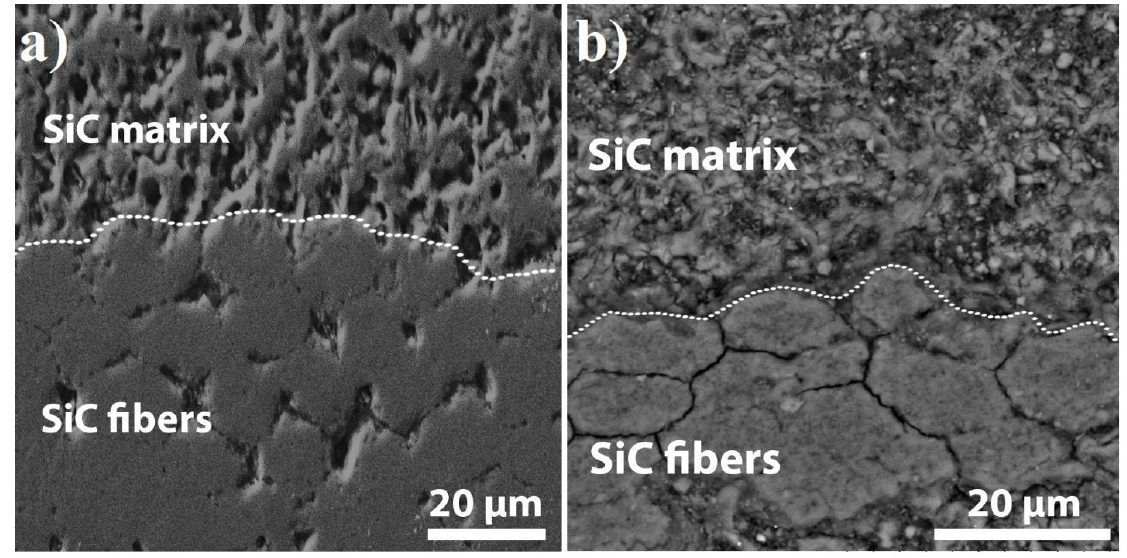
Figure 8. SEM images of SiC f / SiC p composites sintered at 60 MPa for 10 min ( a ) and 3 min ( b ).